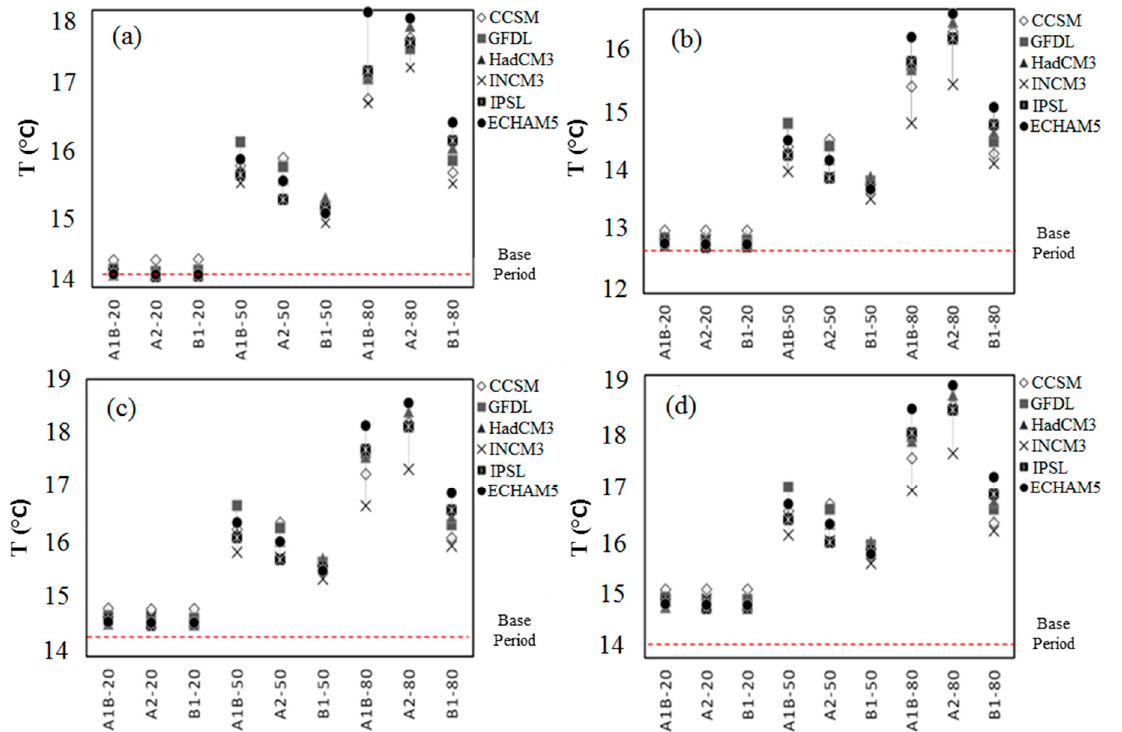
Figure 2. The daily averaged downscaled temperatures based on the A1B, A2, and B1 scenarios for the three time horizons (the 2020s, 2050s, and 2080s) using different GCMs in the sub-basins: SUB-1 ( a ); SUB-2 ( b ); SUB-3 ( c ); and SUB-4 ( d ).